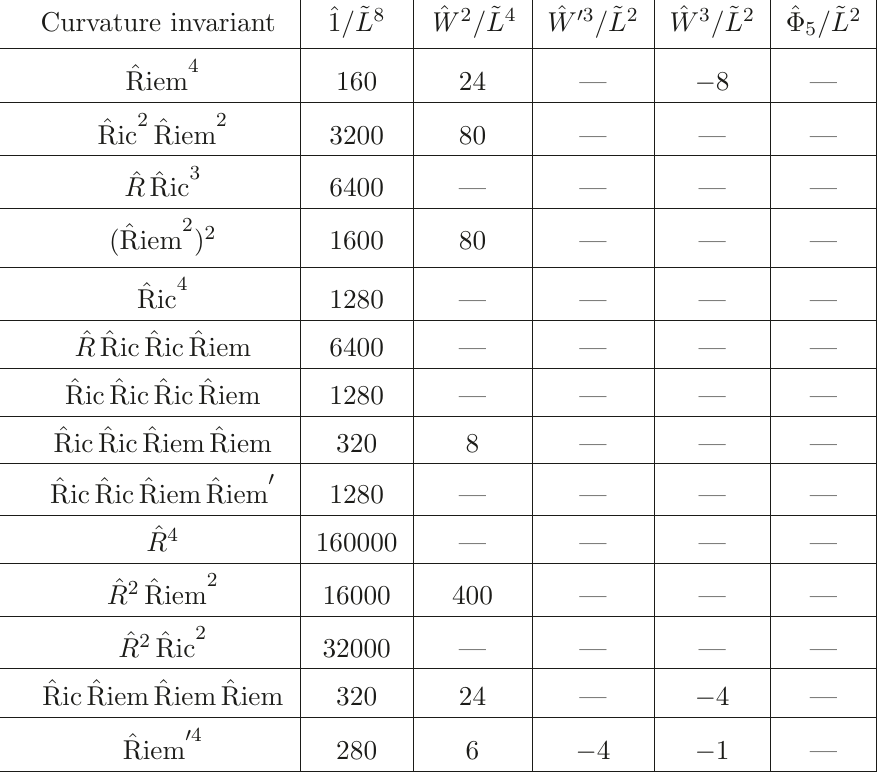
Table 5 . 5D basis of quartic curvature